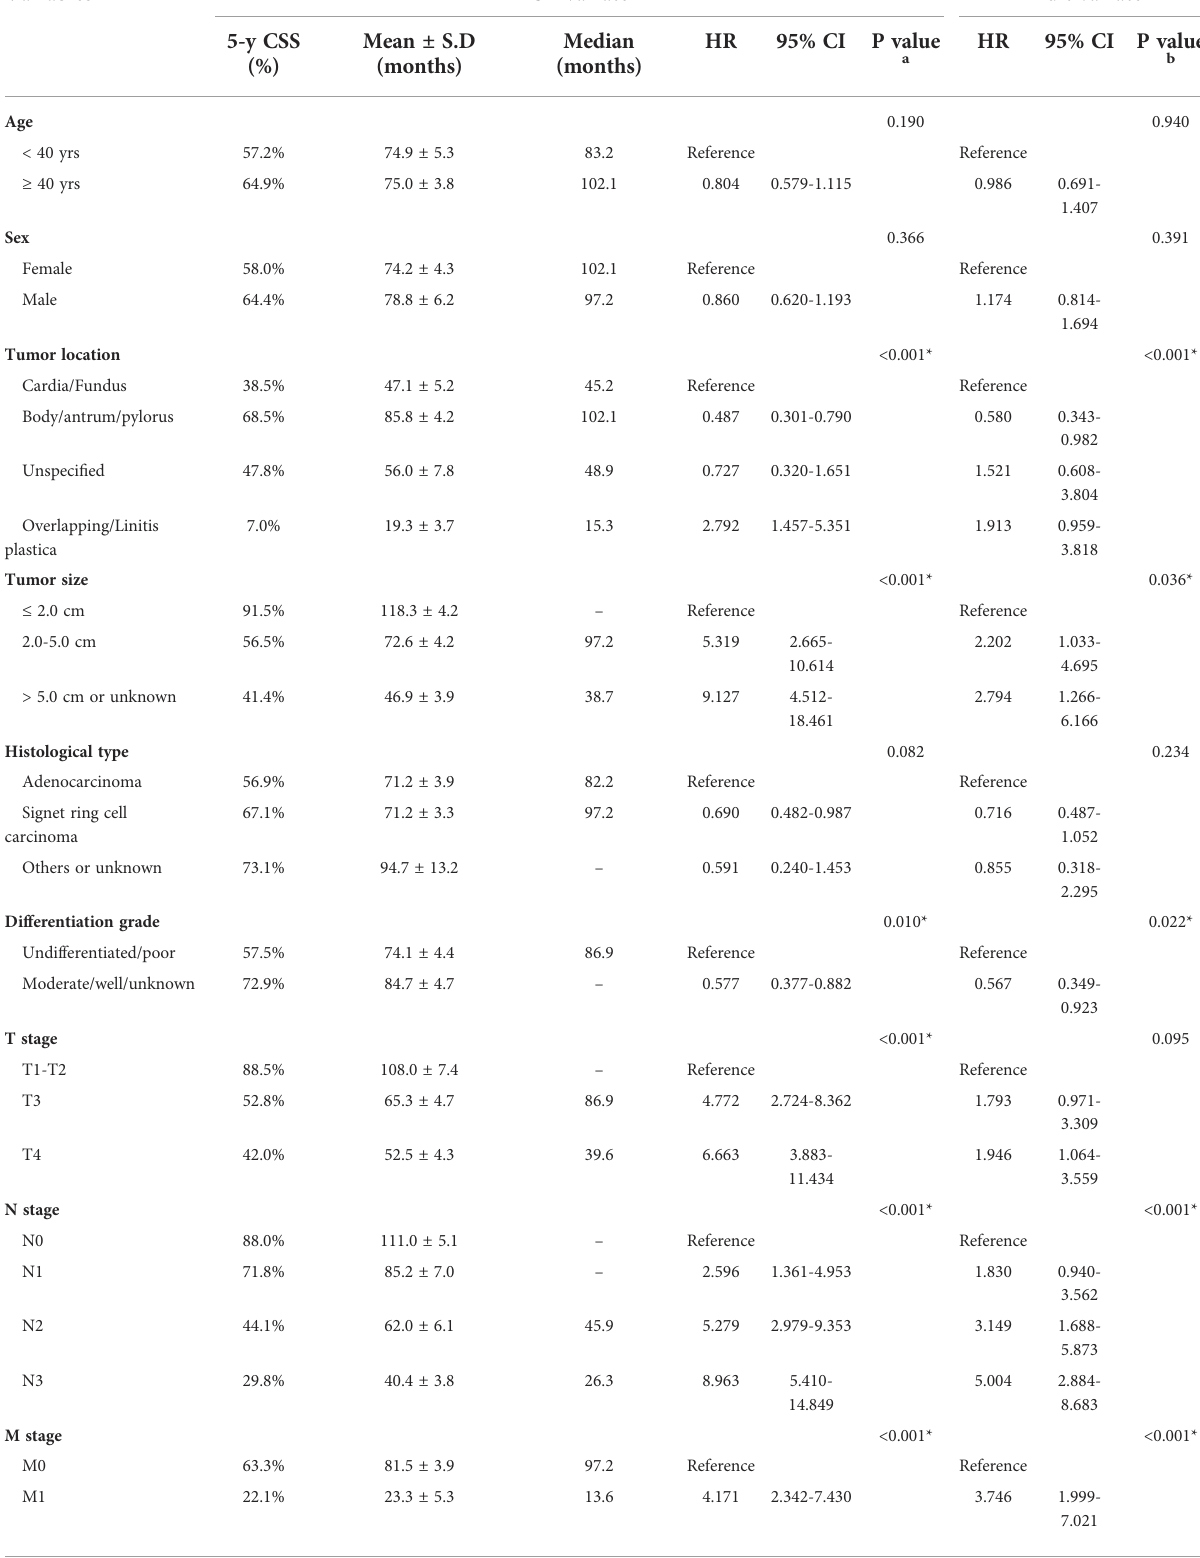
TABLE 2 Univariate and multivariate Cox regression analyses of factors associated with CSS in the training